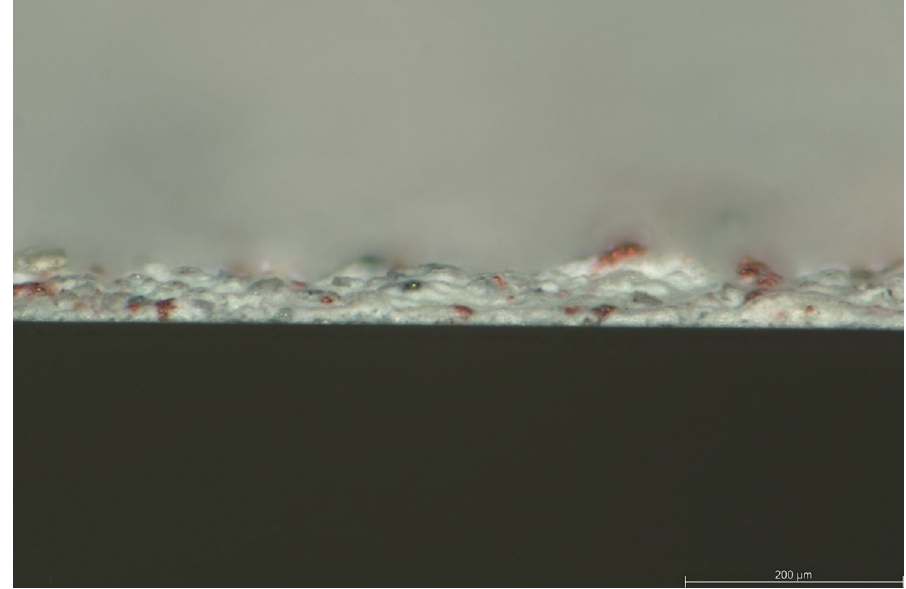
Figure 9. Paint surface, cross section, visible metal grains on undulate surface, scale bar = 200 μ m, Alcor R&D Center unpublished report, project No.